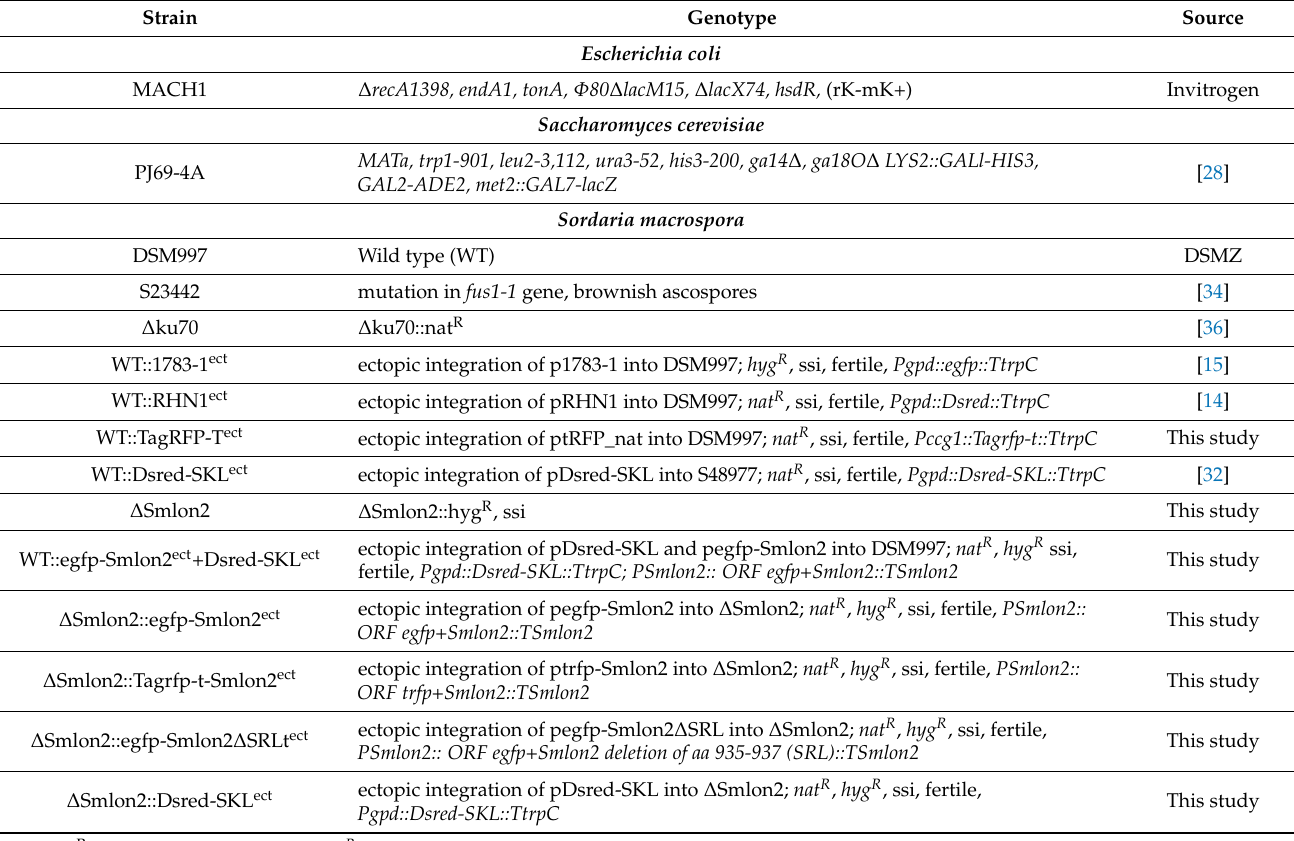
Table 1. Overview of strains used and constructed in this